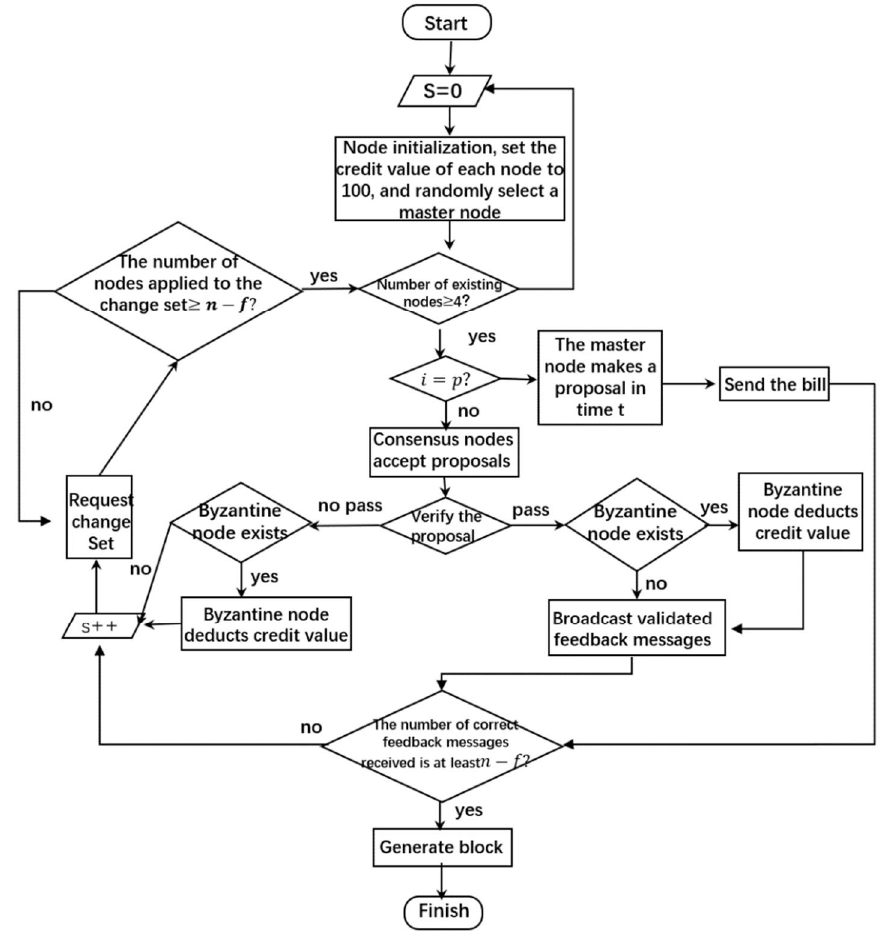
Figure 5. Consensus algorithm flow.